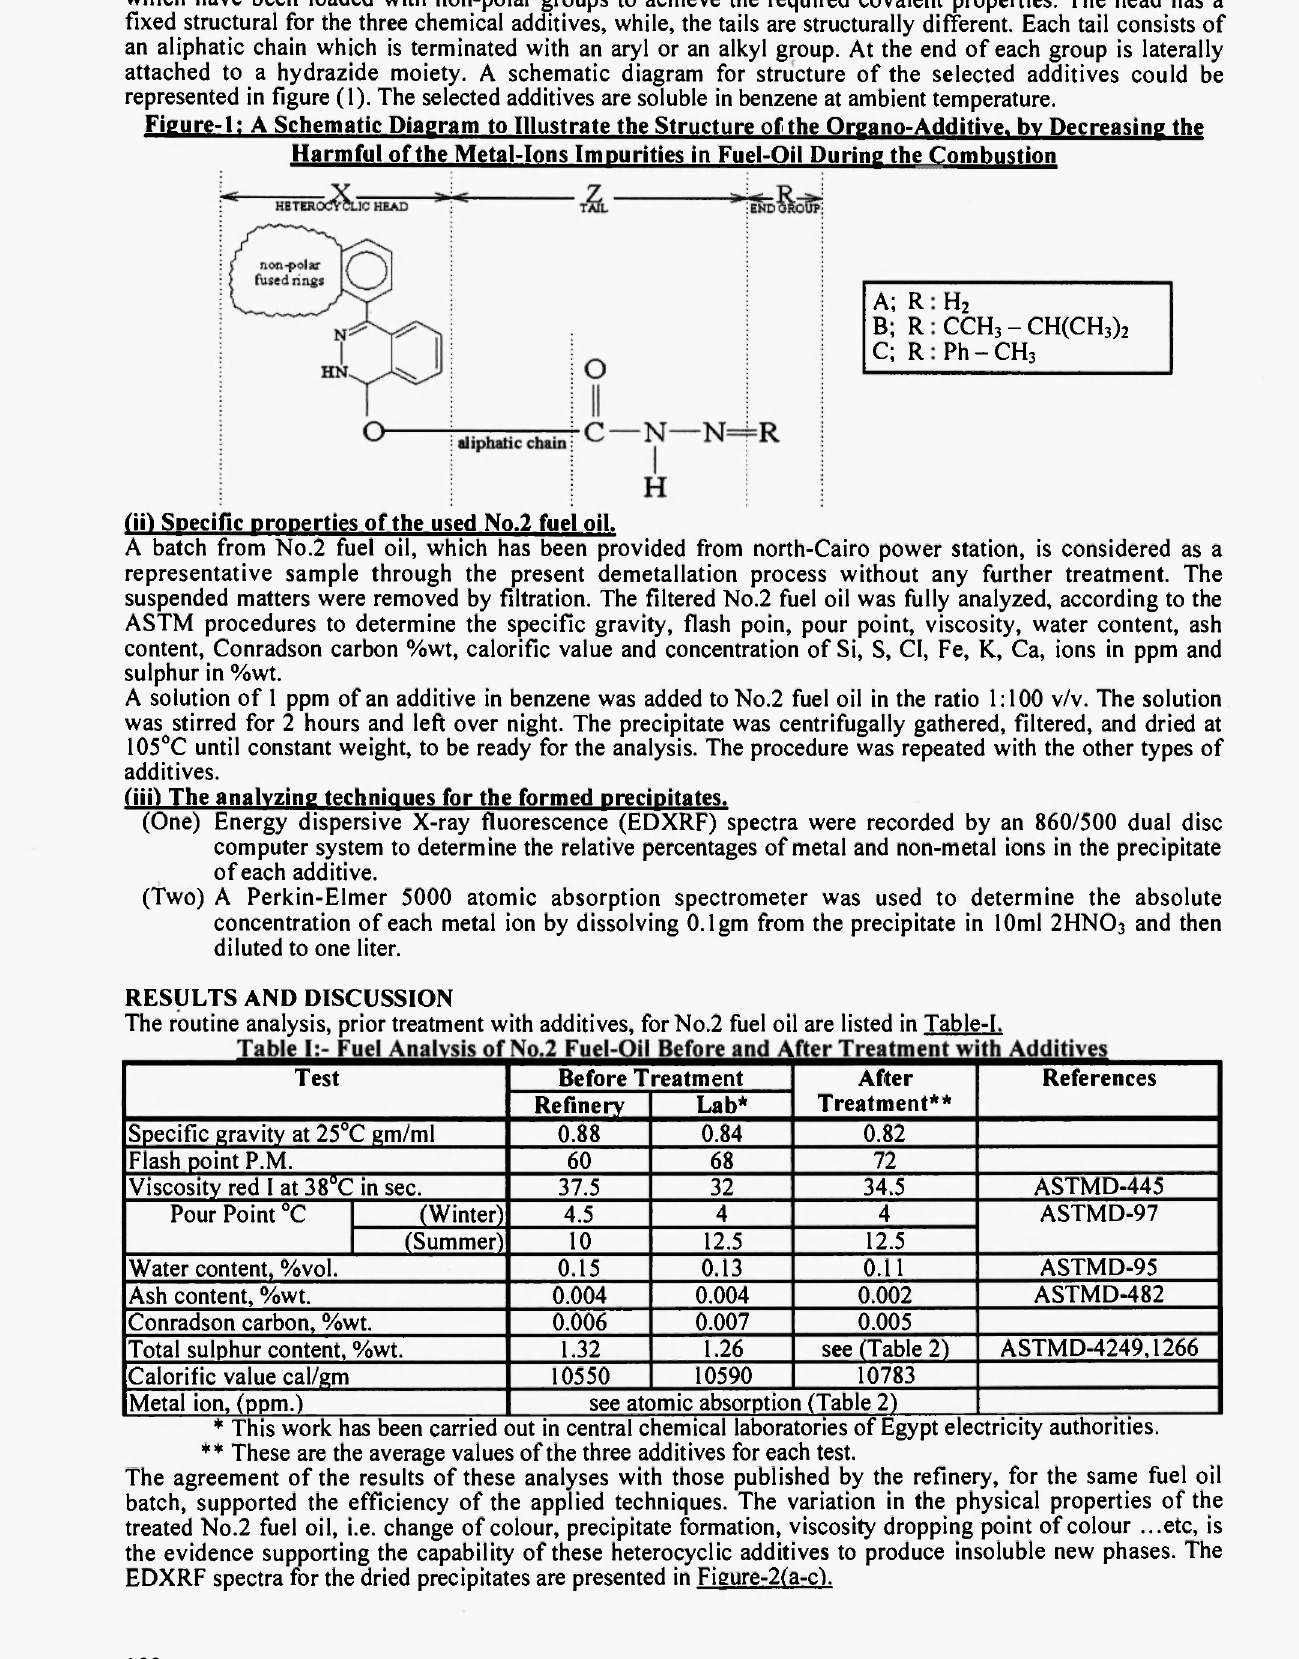
Figure-1: A Schematic Diagram to Illustrate the Structure of the Organo-Additive. by Decreasing the Harmful of the Metal-Ions Impurities in Fuel-Oil During the Combustion